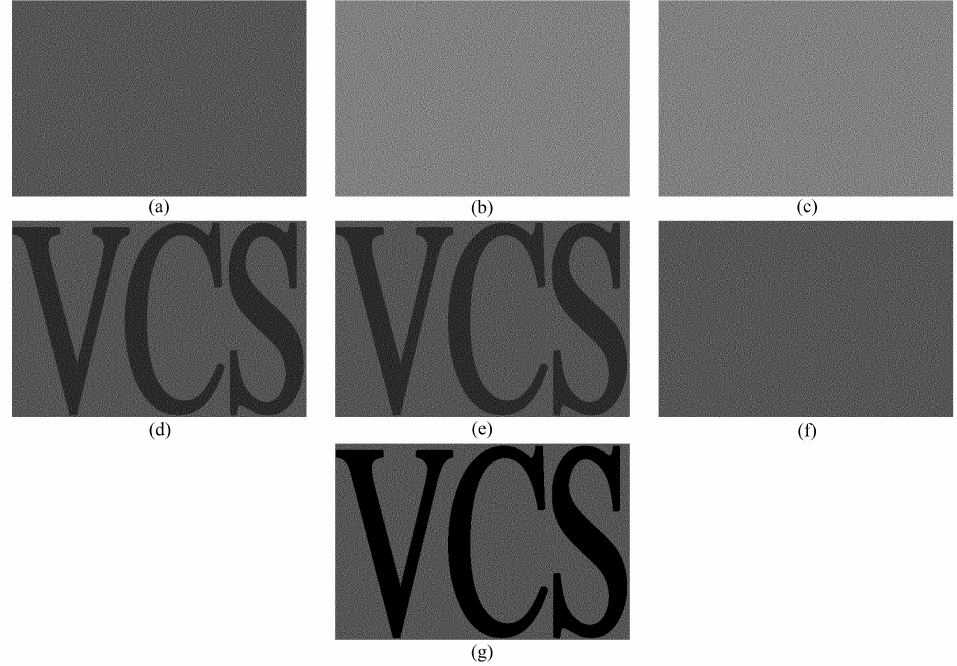
Figure 5. The experimental results of proposed scheme for (1, 1, 2, 3)-EVCS. ( a ) essential shadow; ( b , c ) two non-essential shadows; ( d ) revealed image by shadow 1 and 2; ( e ) revealed image by shadow 1 and 3; ( f ) revealed image by shadow 2 and 3; and, ( g ) revealed image by all shadows.